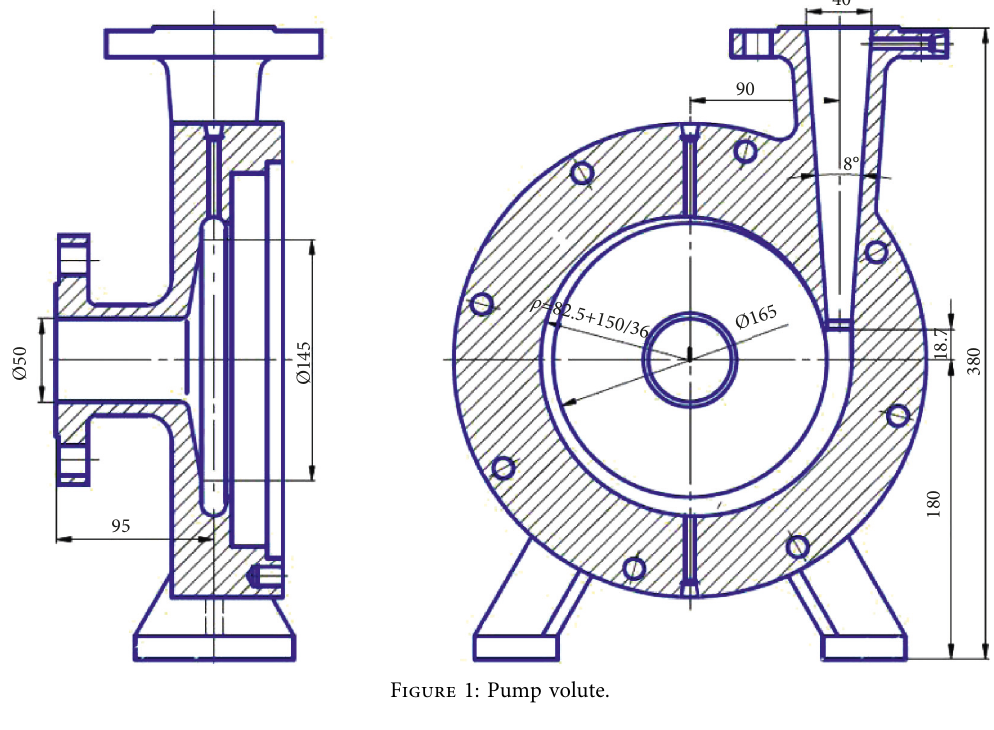
Figure 1: Pump volute.